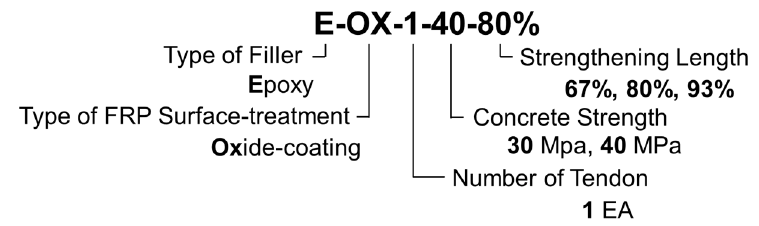
Figure 1. Designation of specimens.